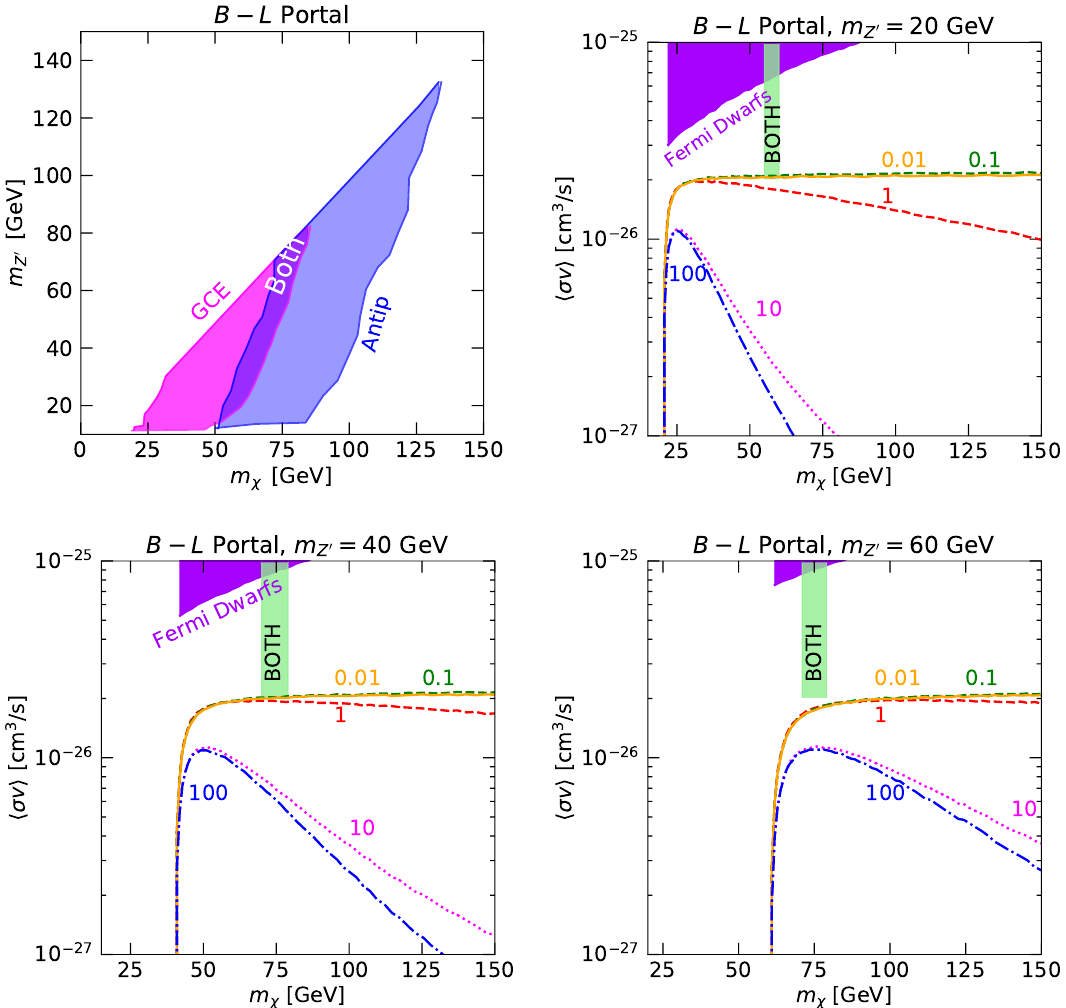
Figure 6 . As in (cid:12)gure 5, but for the case of hidden sector dark matter that annihilates to particles that decay through the B L (cid:0)